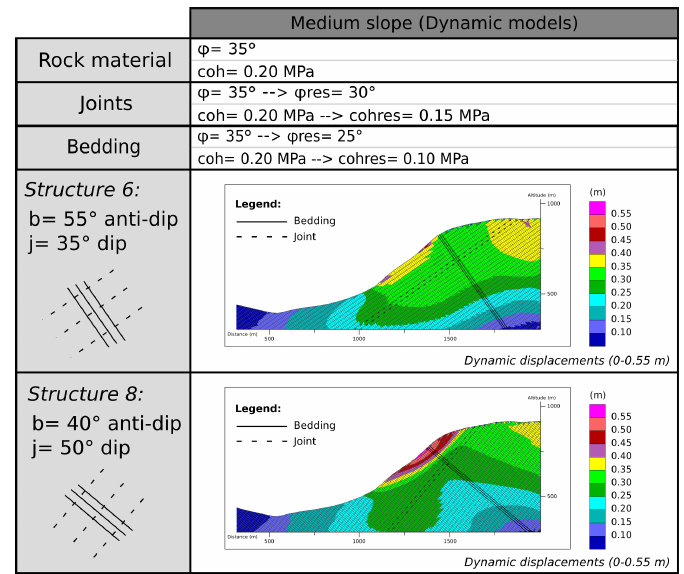
Figure 16. Dynamic modelling results (in terms of displacements) for the rock slope conditions closest to the Balta case, with anti-dip slope bedding structure.